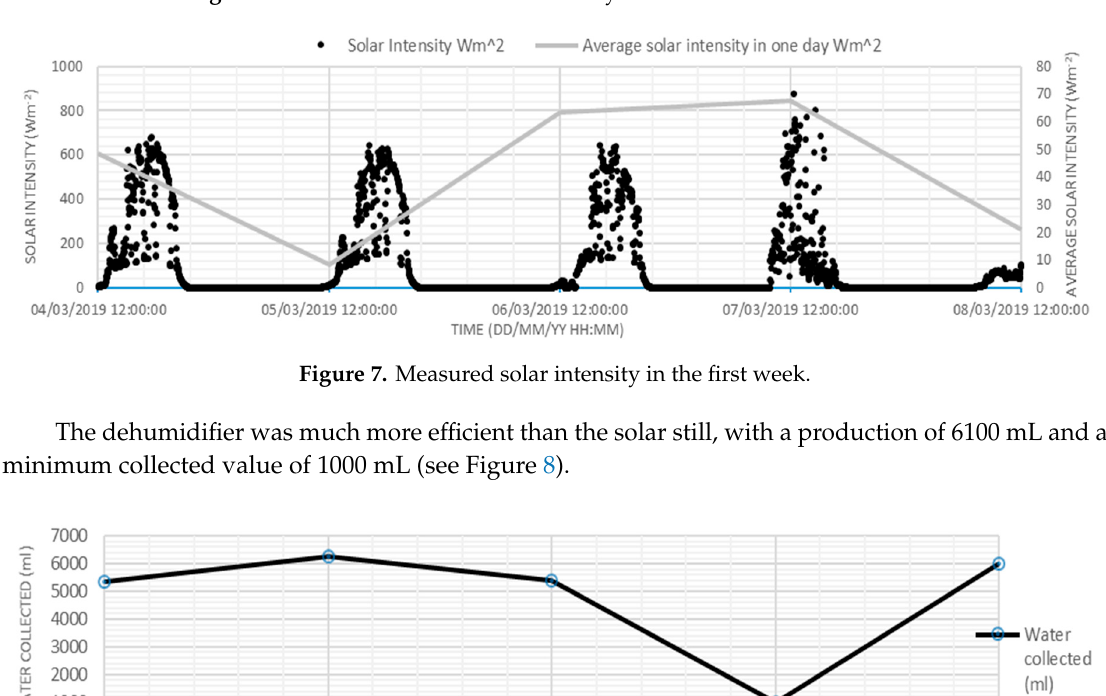
Figure 6. The amount of water collected by the solar still in the first week.